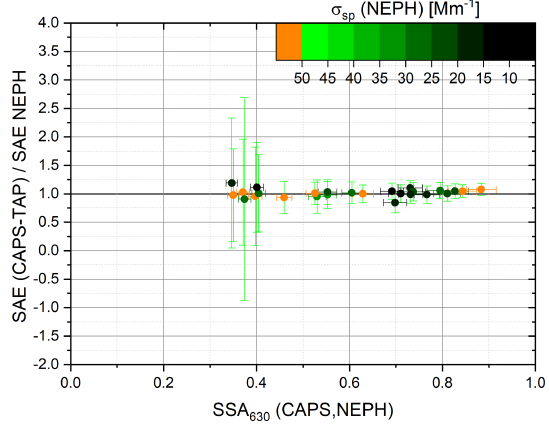
Figure 12. The scattering Ångström exponent ratio, SAE(CAPS, TAP)/SAE(NEPH), as a function of 630nm wavelength SSA(NEPH, CAPS) values for AQ–AS mixtures. The 630nm wavelength light-absorption coefficient, σ ap (TAP), is used as the colour